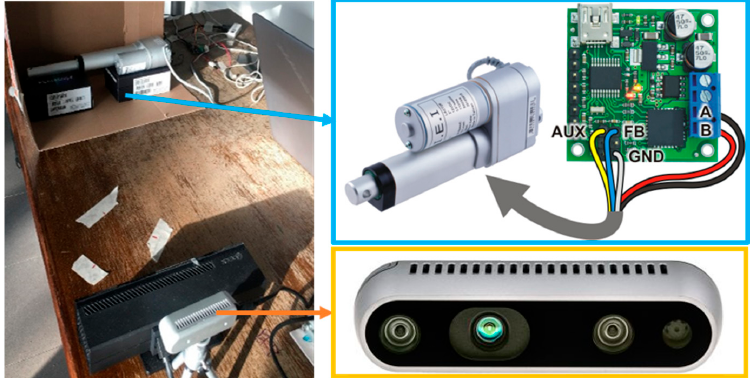
Figure 1. Test bench adopted for measurement: linear actuator, board control and 3D acquisition camera.